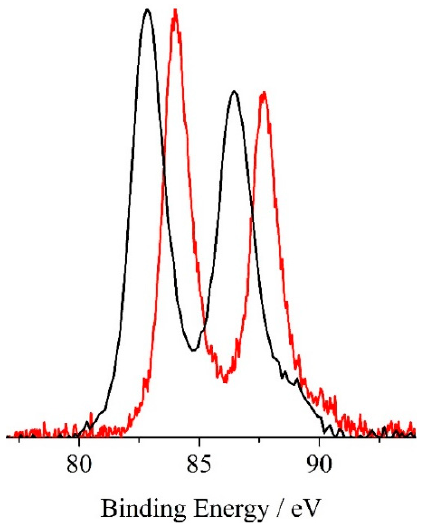
Figure 4. Al-K α excited XPS of the pure Au NPs solution (red line) and Au NPs–porphyrin system (black line) in the Au 4f binding energy region.